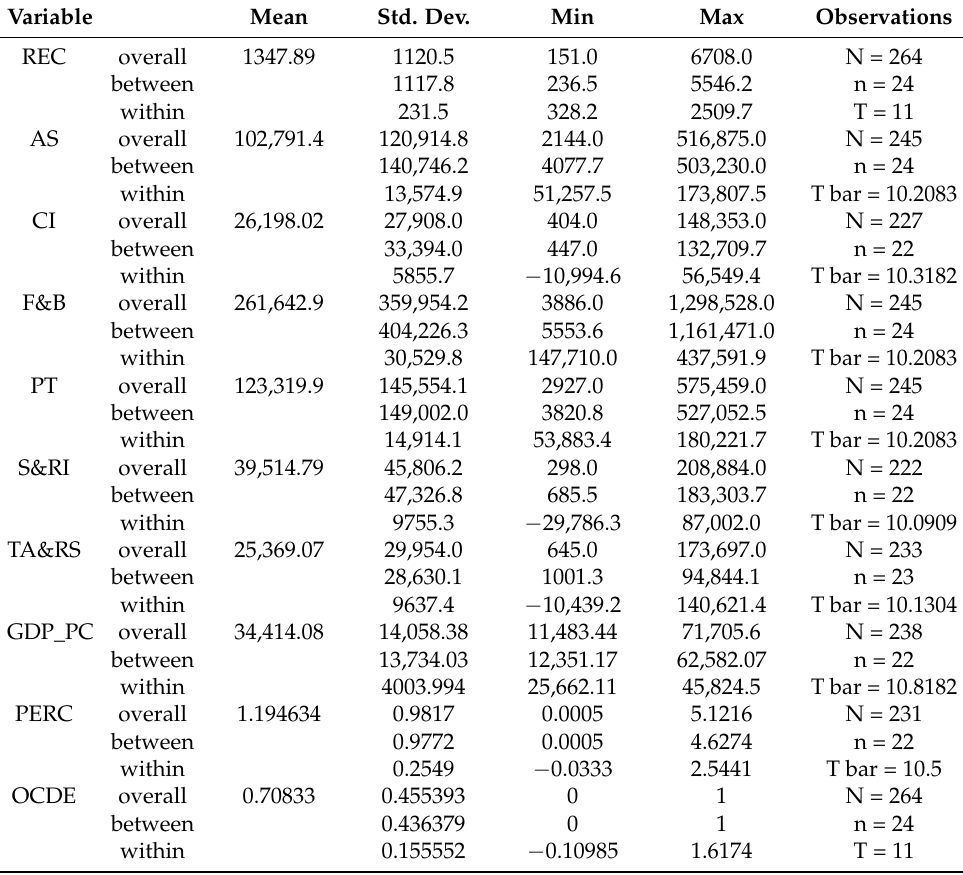
Table A3. Descriptive statistics of the panel.